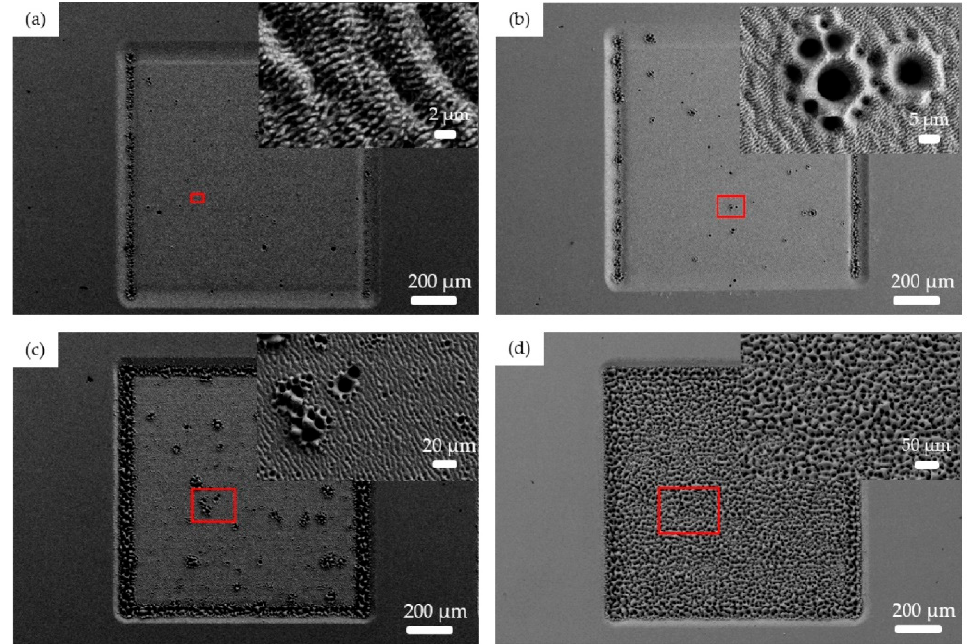
Figure 2. Femtosecond laser-induced surface micro-structure morphology by SEM at 120 µJ ( a ) 5 scans; ( b ) 10 scans; ( c ) 20 scans; ( d ) 30 scans. ( a ) 5 scans; ( b ) 10 scans; ( c ) 20 scans; ( d ) 30